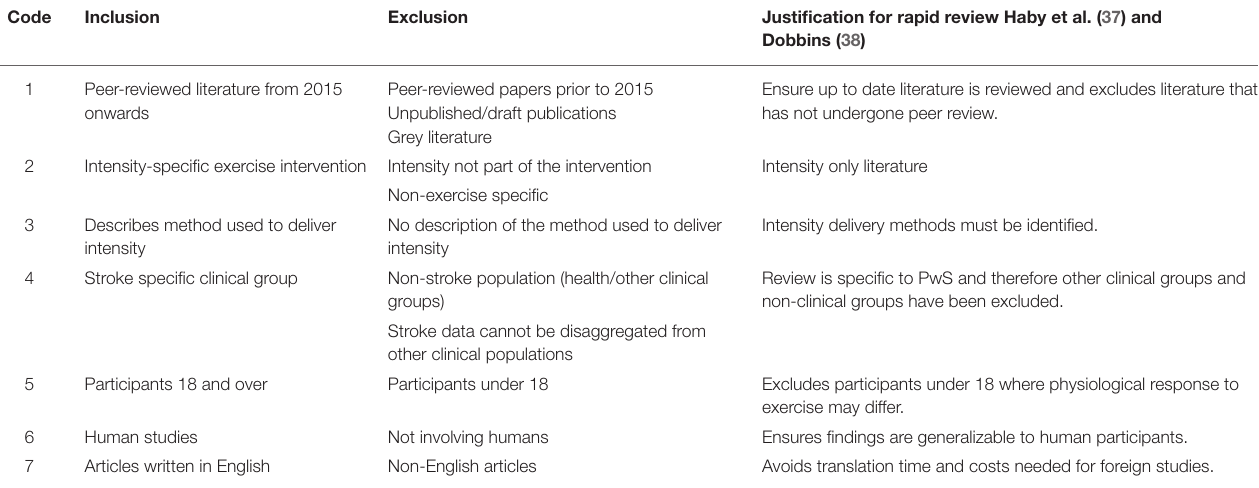
TABLE 1 | Eligibility criteria for inclusion and exclusion and their justification.